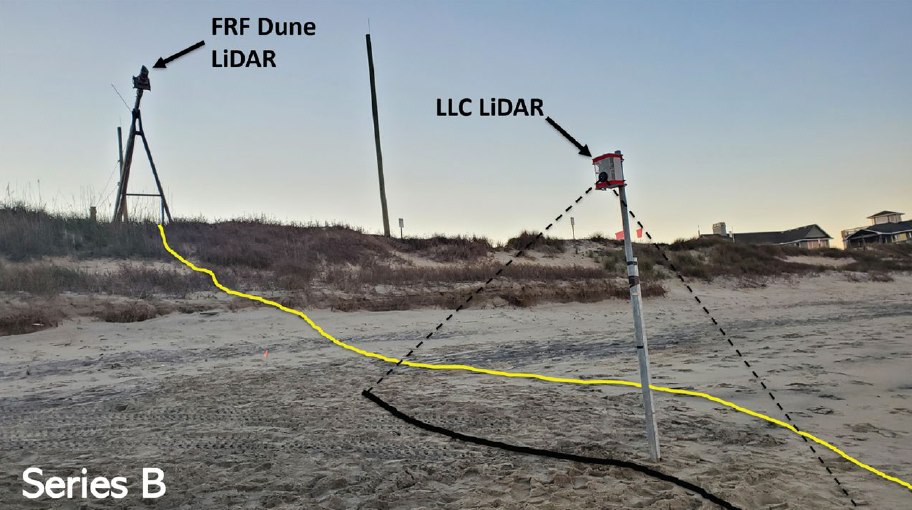
Figure 4. The FRF DUNE LiDAR and LLC LiDAR (Series B) deployed at the USACE FRF. The approximate LLC LiDAR profile range and field of view are drawn as solid and dashed black lines, respectively ( y FRF ≈ 942 m). The yellow line denotes the approximate cross-shore transect measured by the FRF DUNE LiDAR ( y FRF ≈ 945 m). During each series, the LLC LiDAR scanned continuously for the first 25 min of every half hour at ~7 revolutions per second, with an average angular resolution, d θ , of 1.3 ◦ . A total of 35 (28) 25-min segments were collected during Series B (Series C). The FRF DUNE LiDAR performed line scans at 7.1 Hz during the first 30 min of every hour, yielding hourly time-averaged beach profiles and 30-min time series of wave runup excursion and elevation [15]. During Series C, waves and water levels were measured directly beneath the LLC LiDAR using an RBR solo 3 D|wave16 pressure logger sampling continuously at 16 Hz above the beach with the pressure diaphragm at 0.46 m, NAVD88 (Figure 3). The